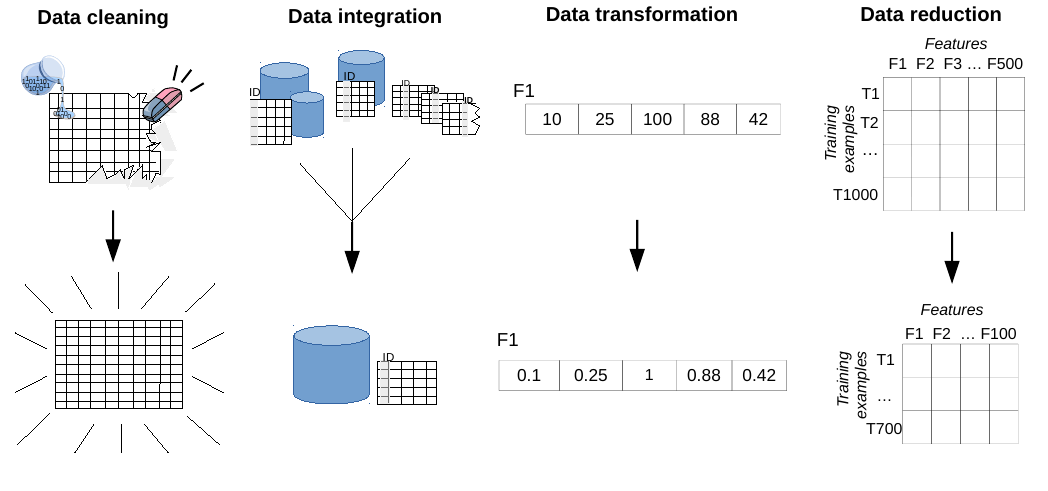
Figure 5. Data Pre-Processing